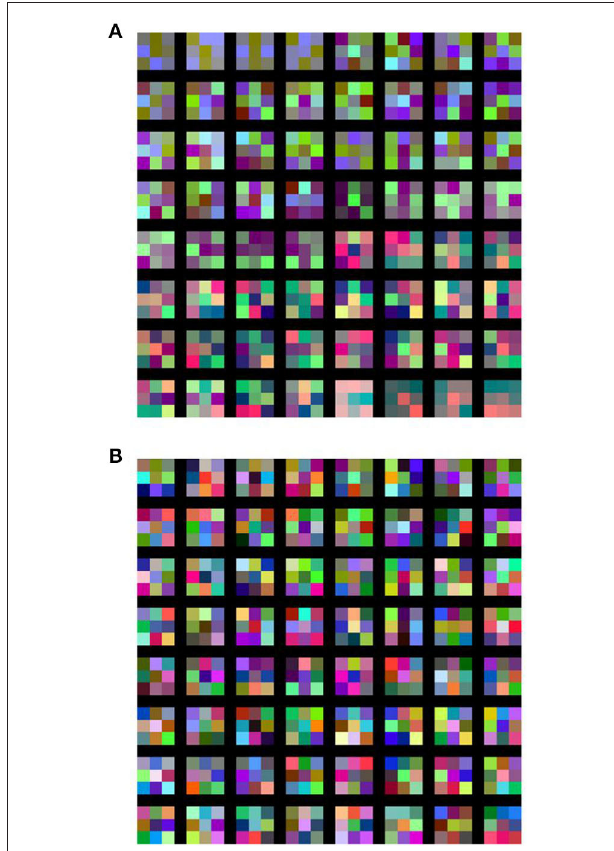
FIGURE 5 | Learned filters of (A) schizophrenia convolution layer and (B) conventional convolution layer. In the schizophrenia network, the first convolution layer of the VGG16 network ( Table 1 , network E) was replaced with a schizophrenia convolution layer, in which 41.7% of the weights were eliminated with a diagonal